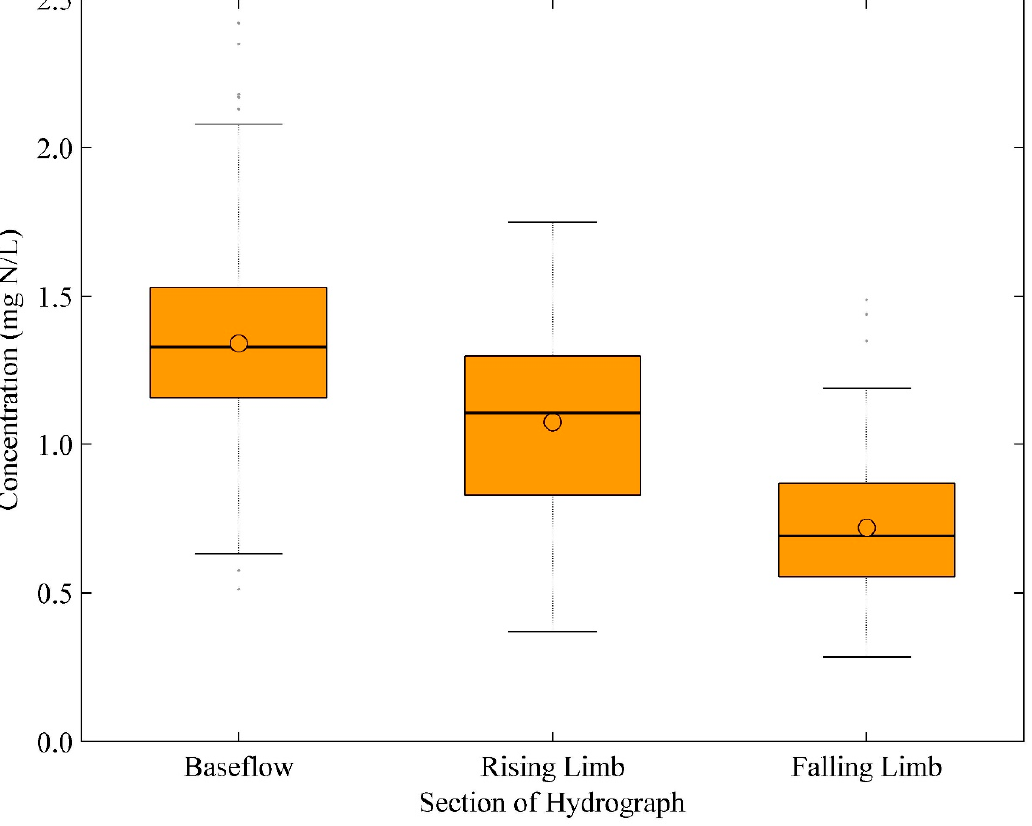
Figure 4. Box plot of USGS samples of nitrate concentration during various sections of the hydrograph. The error bars and circles inside the colored boxes represent the median and mean of the data. The lower and upper edges of boxes represent 25th and 75th percentiles. The error bars outside the colored boxes represent the 10th and 90th percentiles, and the dots represent 5th and 95th percentiles.